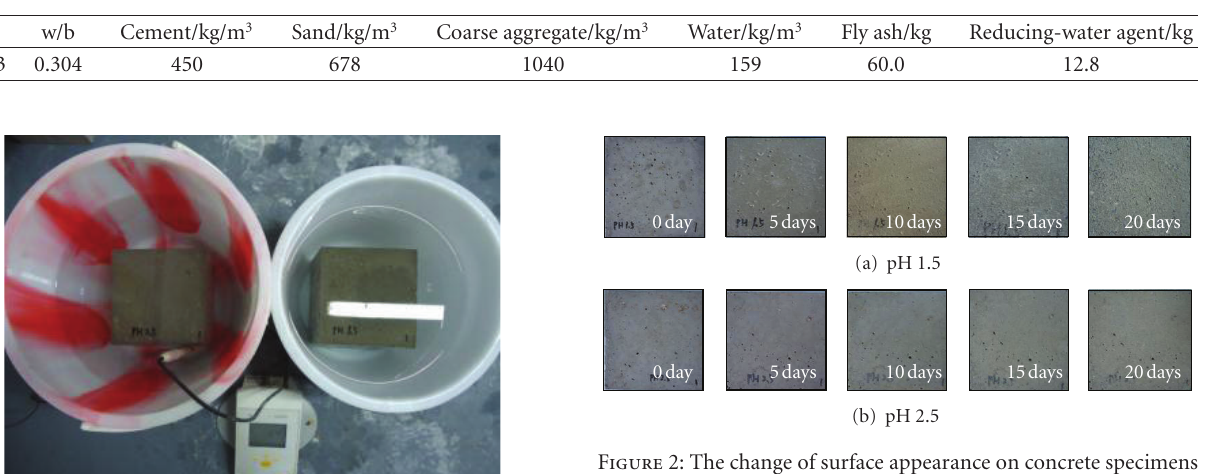
Table 1: Mix proportion of the concrete mixtures.